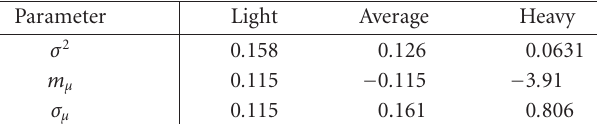
Table 1: Parameters for various degrees of